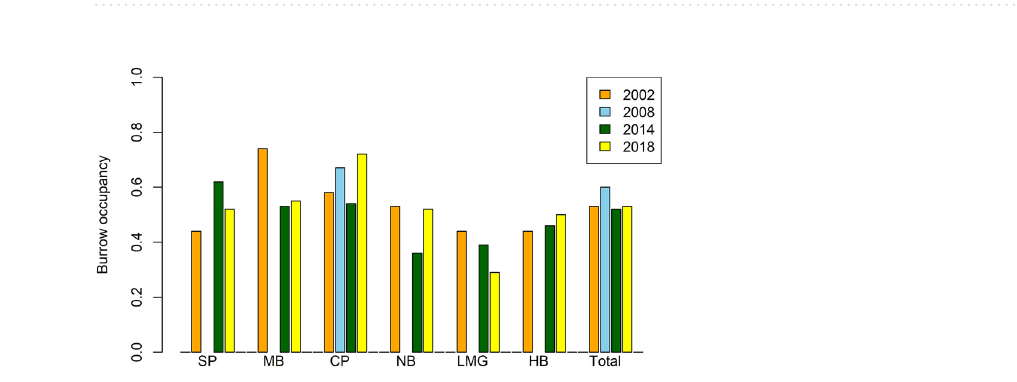
Figure 3. ( a ) Estimated number of flesh-footed shearwater burrows at each colony in all four years, and ( b ) estimated total burrows on Lord Howe Island.